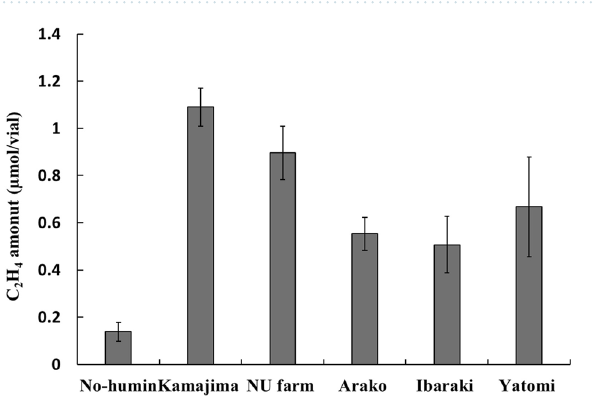
Figure 2. Effects of various humins on ARA of the no-humin consortium. All humins examined promoted ARA of the no-humin consortium. Kamajima humin yielded the highest ARA in the no-humin